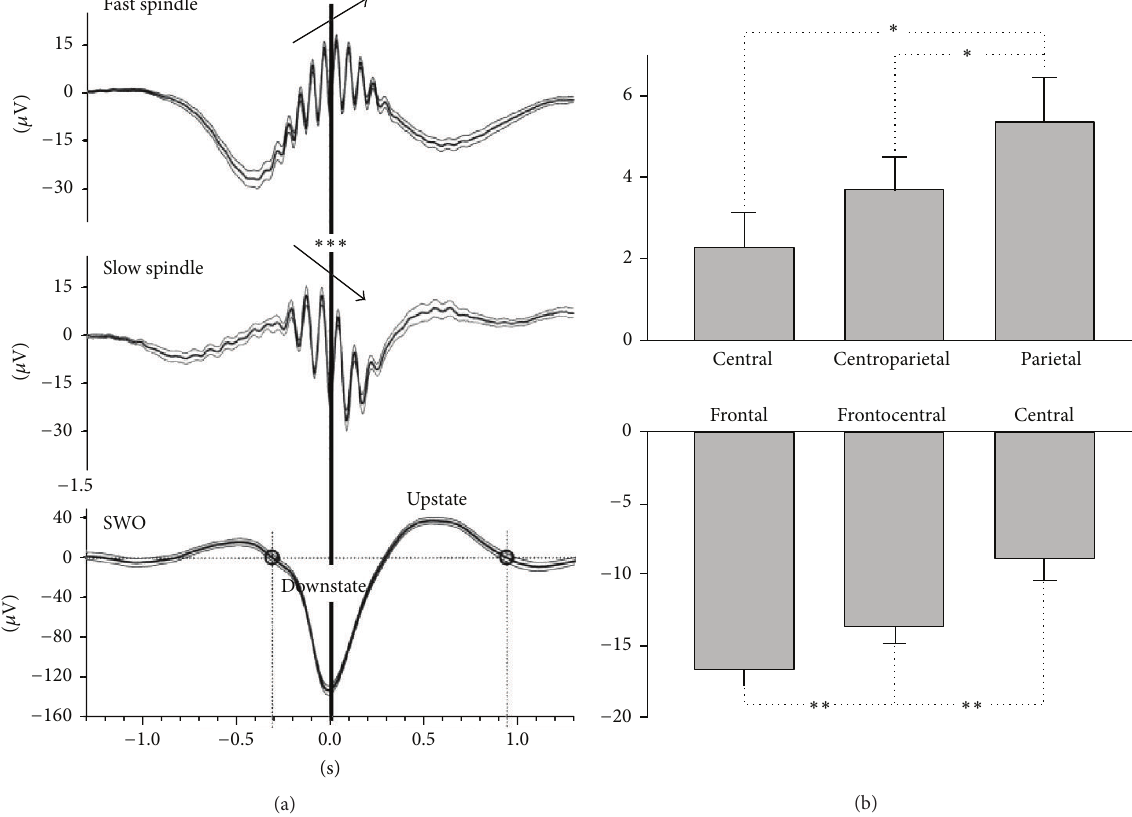
Figure 6: Late slow and early fast spindles with the Slow Wave Oscillation (SWO). (a) Grand mean averages ( ± SEM) of original EEG in (top) 12 centroparietal channels across all detected fast spindles, in (middle) 12 frontocentral channels across all detected slow spindles, and (bottom) in 8 frontocentral channels across all detected slow oscillations. Note that spindles are averaged independently of whether an SWO was present. Averaging was performed with reference to the deepest, that is, most negative, trough in the filtered signal ( 𝑡 = 0 ). Asterisks (and arrows) indicate a significant ( 𝑃 < 0.001 ) positive and negative slow potential shift underlying early fast and late slow spindles, respectively, in the interval between 300 ms before and 300 ms after the spindle peak. (b) Potential shifts underlying early fast spindles and late slow spindles. Mean ( ± SEM) slow potential shifts underlying (top) early fast spindles at central, centroparietal, and parietal electrodes and (bottom) late slow spindles at frontal, frontocentral, and central electrodes. Asterisks indicate significant differences between topographies in positive and negative slow potential shifts, respectively ( ∗∗ 𝑃 < 0.01 , ∗ 𝑃 < 0.05 ). Modified from